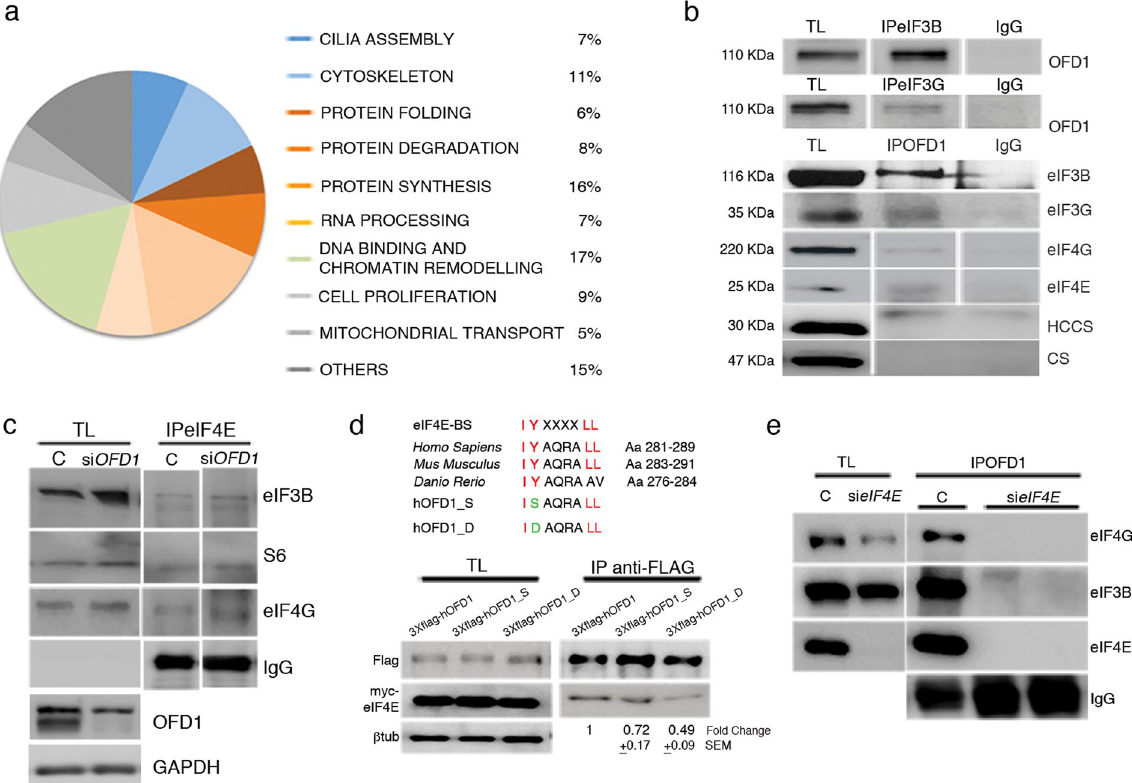
Figure 1. OFD1 interacts with the translational machinery. ( a ) OFD1 interactome. The putative OFD1 partners were clusterized in functional classes, which are identified by a color code. The majority of interactors are involved in the control of the cellular protein content (different shades of orange and red). ( b ) OFD1 interacts with components of the PIC and the eIF4F complex. Co-IP experiments performed on total lysates (TL) from HEK293 cells. (Upper panels) eIF3B and eIF3G were immunoprecipitated and OFD1 was detected by WB. (Lower panels) OFD1 was immunoprecipitated and different subunits of the PIC and of the eIF4F complex (eIF3B, eIF3G, eIF4G, eIF4E) were detected by WB. IgG were used as control. Holocytochrome-c type-synthase (HCCS) and Citrato synthase (CS) were used as negative controls. All lanes are from the same blot. However some of the lanes were not adjacent and are separated by a space. ( c ) Co-IP experiments demonstrate that eIF4E binds other PIC and eIF4F components (eIF3B, eIF4G and S6) in OFD1 silenced cells. Lower panel in c reports the effect of OFD1 silencing at the protein level. ( d ) OFD1 directly binds eIF4E. An eIF4E binding site (eIF4E-BS, Aa in red) is recognized in the OFD1 protein and conserved in OFD1 vertebrate homologs. Aa mutagenized within the eIF4E-BS are depicted in green. Co-Ip experiments demonstrated that the mutated constructs show a lower affinity for eIF4E (right panel). β tubulin was used as loading control. TLs are reported on the left. The eIF4E/OFD1 ratio was calculated and the fold change was reported below the panels as the mean ± standard error of the mean (SEM). ( e ) eIF4E mediates the interaction of OFD1 with eIFs. OFD1 was immunoprecipitated in control and eIF4E -silenced HEK293 cells and eIF4G, eIF3B and eIF4E were detected by WB. IgG were used as loading